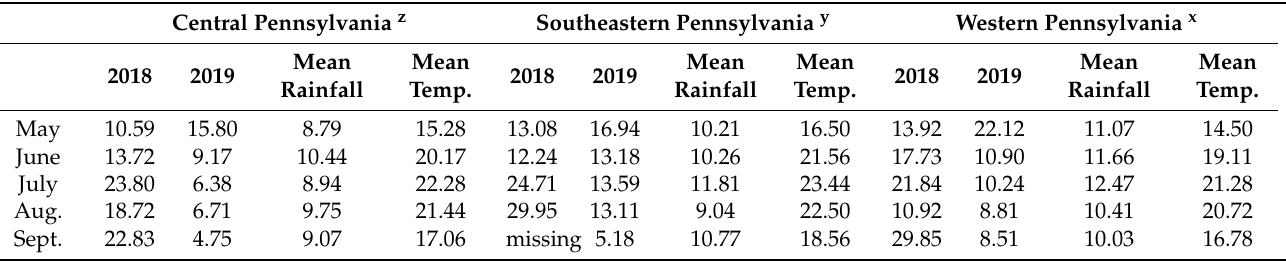
Table 10. Rainfall amount (centimeters) and temperature (degrees Celsius) at three sites of muskmelon cultivar evaluation in